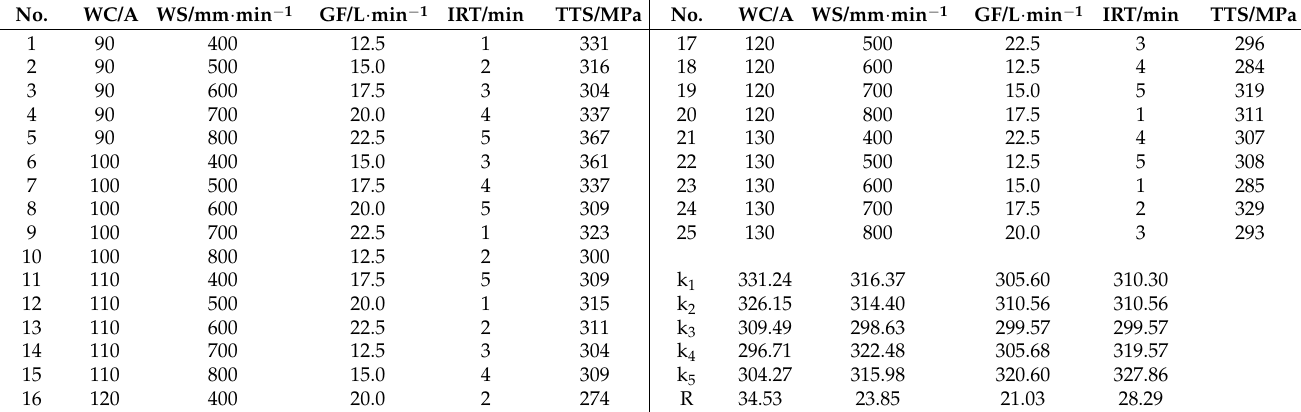
Table 3. Experimental results of transverse tensile strength under orthogonal process